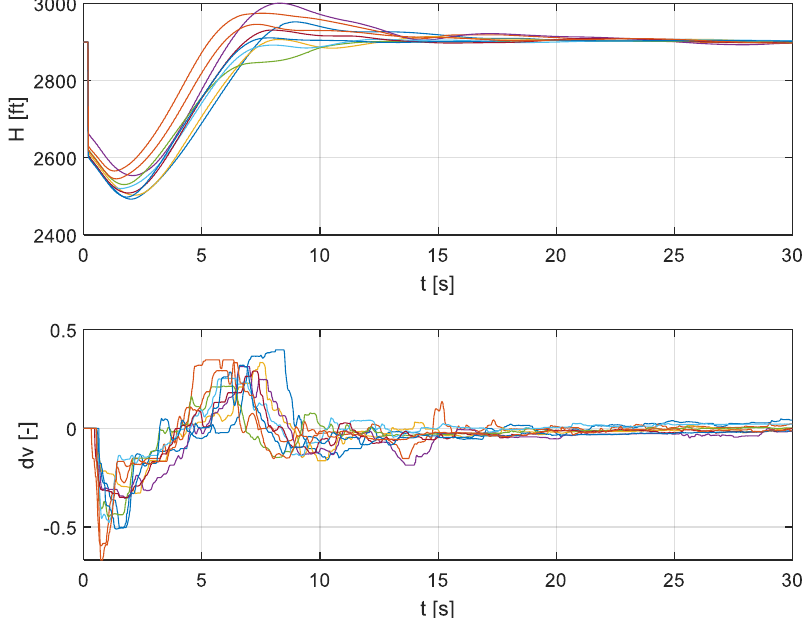
Figure 4. Data representing altitude, H —perceived input signal ( upper ) and control action ( bottom ) of Pilot No. 1 (10 repeated measurements).